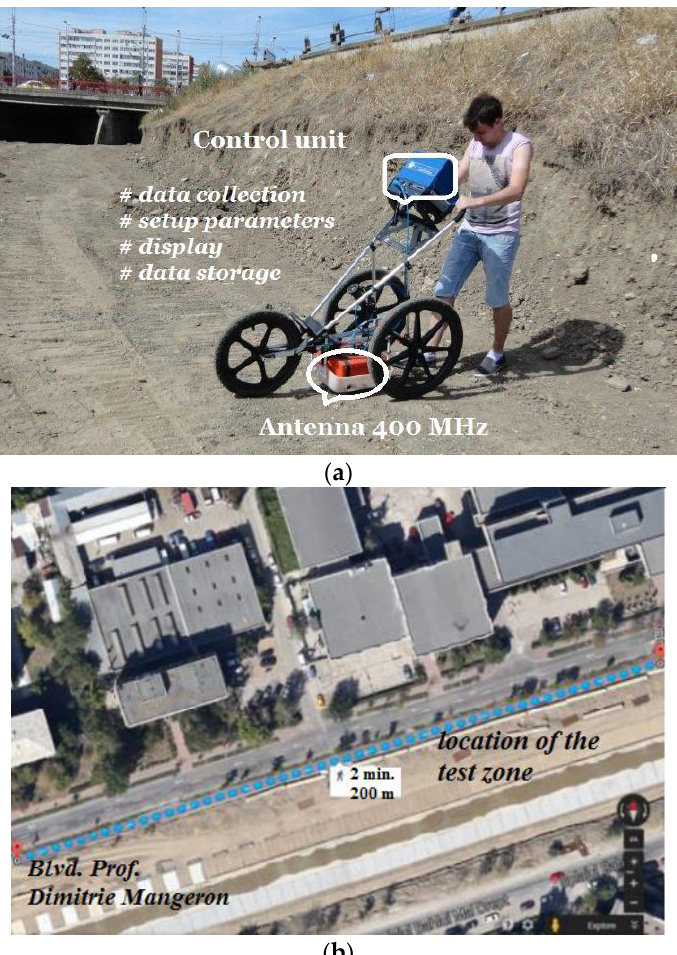
Figure 2. Experimental set-up: ( a ) GPR survey system with a 400-MHz antenna; ( b ) test area of the underground urban drainage pipes.